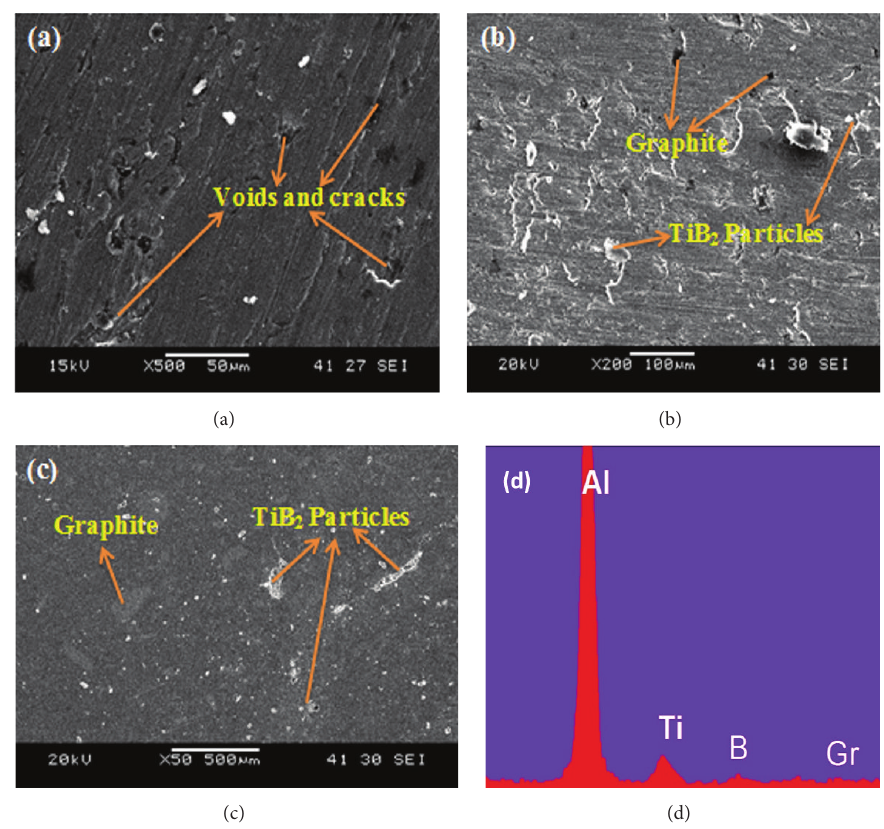
Figure 7: SEM images of Al 7075/TiB 2 /Gr hybrid composites: (a) Al 7075/0% wt. TiB 2 /1% Gr, (b) Al 7075/3% wt. TiB 2 /1% Gr, (c) Al 7075/6% wt. TiB 2 /1% Gr, and (d) sum spectrum produced by